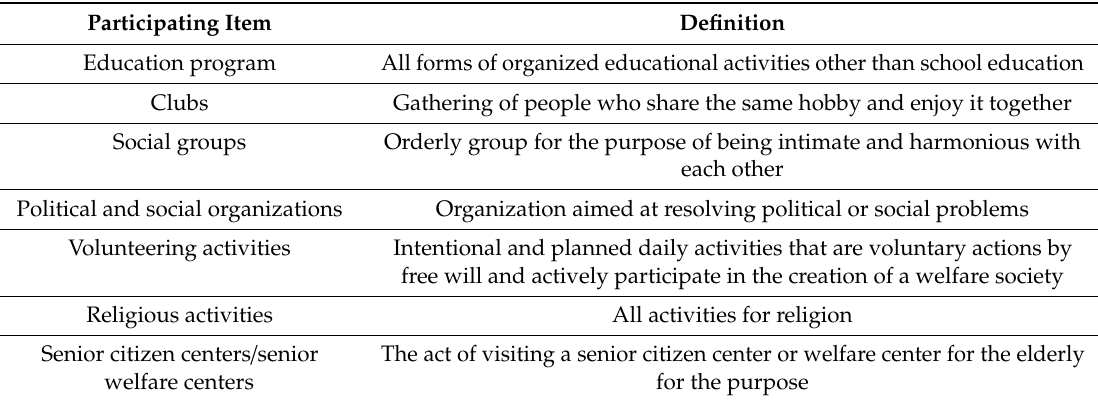
Table 3. Definition of social leisure